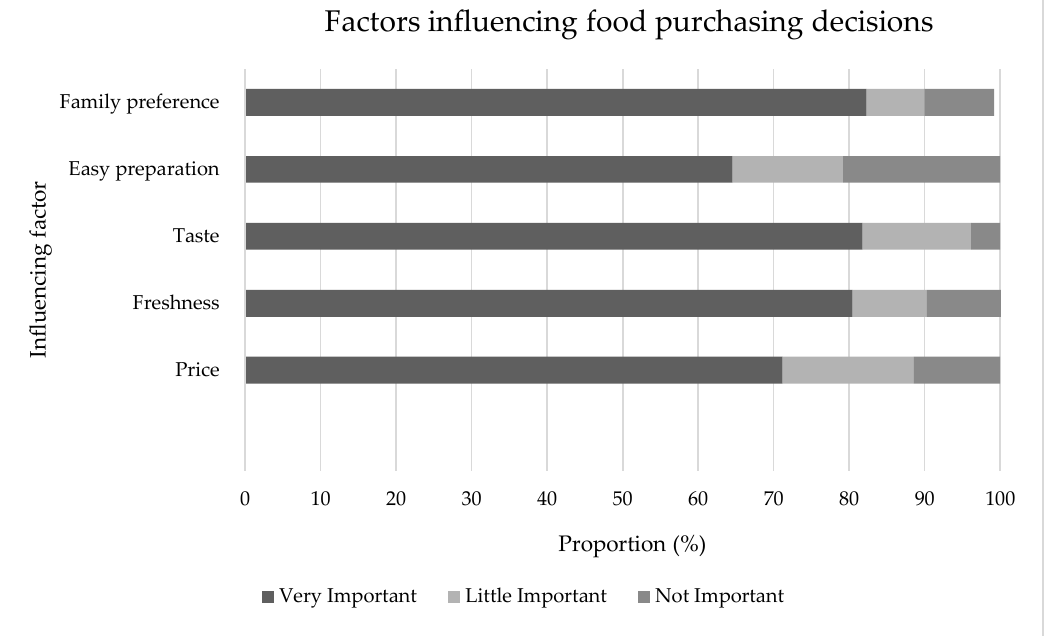
Figure 2. The level influence of price, freshness, taste, easy preparation and family preference on food purchasing behavior of participants.